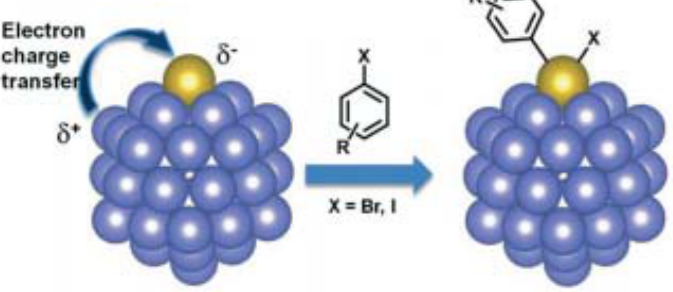
Figure 2. Electronic transfer from Ni (blue) to Pd (yellow) and the oxidative addition of aryl halides on Pd atoms. Reproduced from reference [24] with permission of The Royal Society of Chemistry.